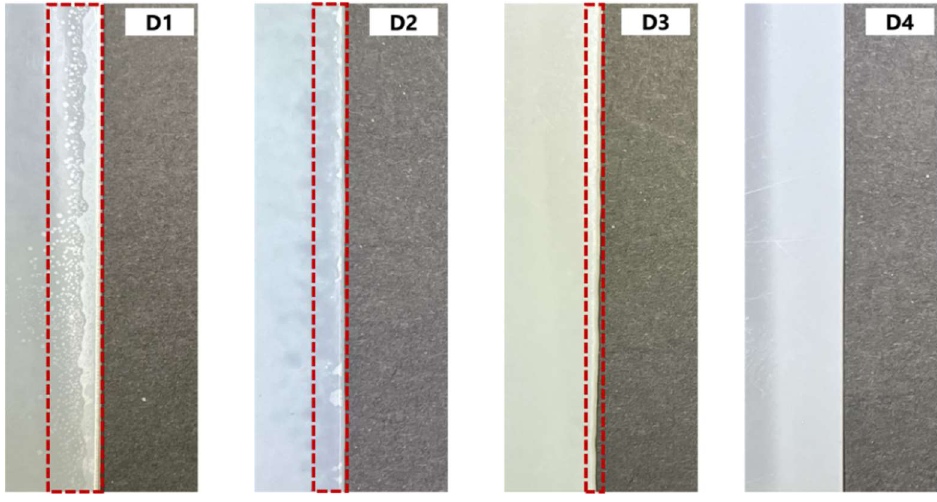
Figure 7. Photos of Samples D1–D4. Table 1. The compositions (wt.%) of all